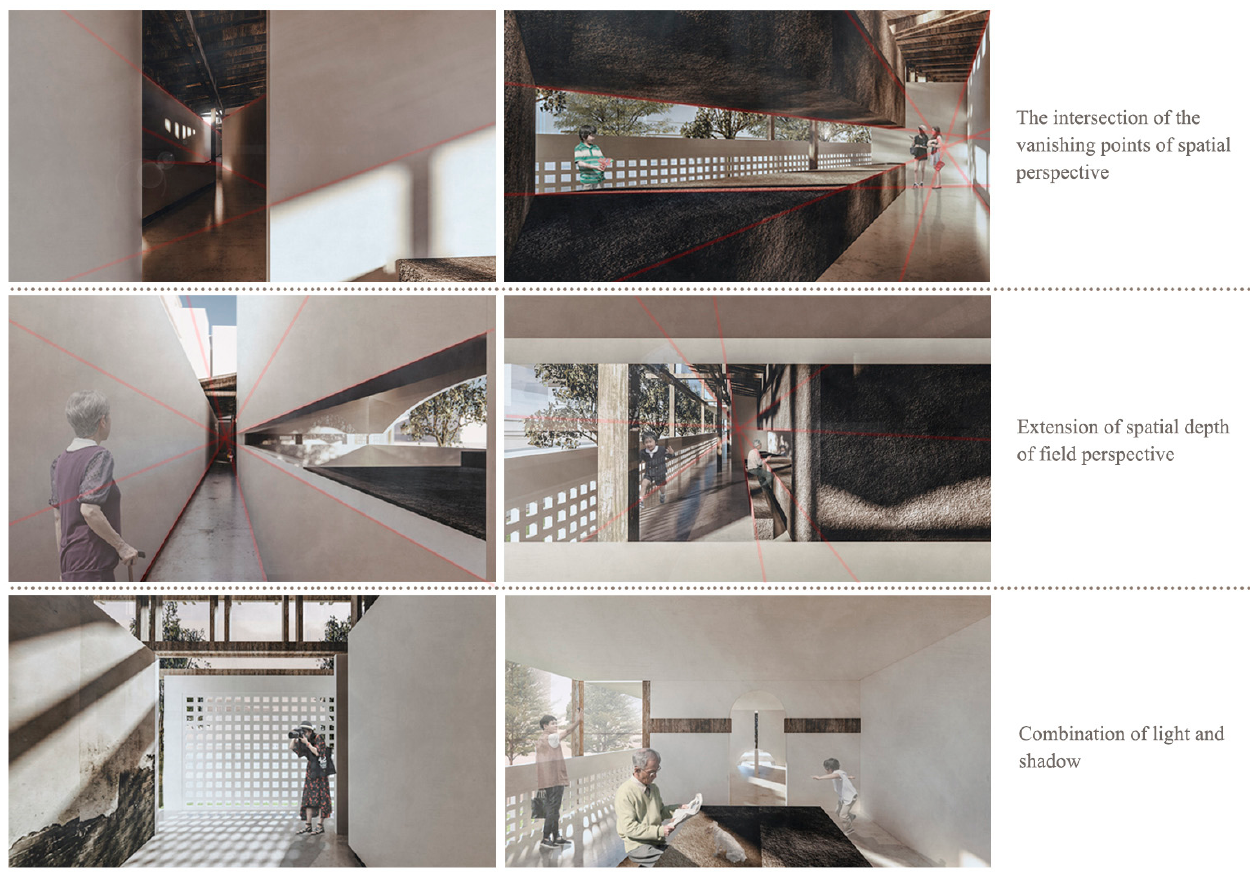
Figure 13. Method of Schema Reproduction.